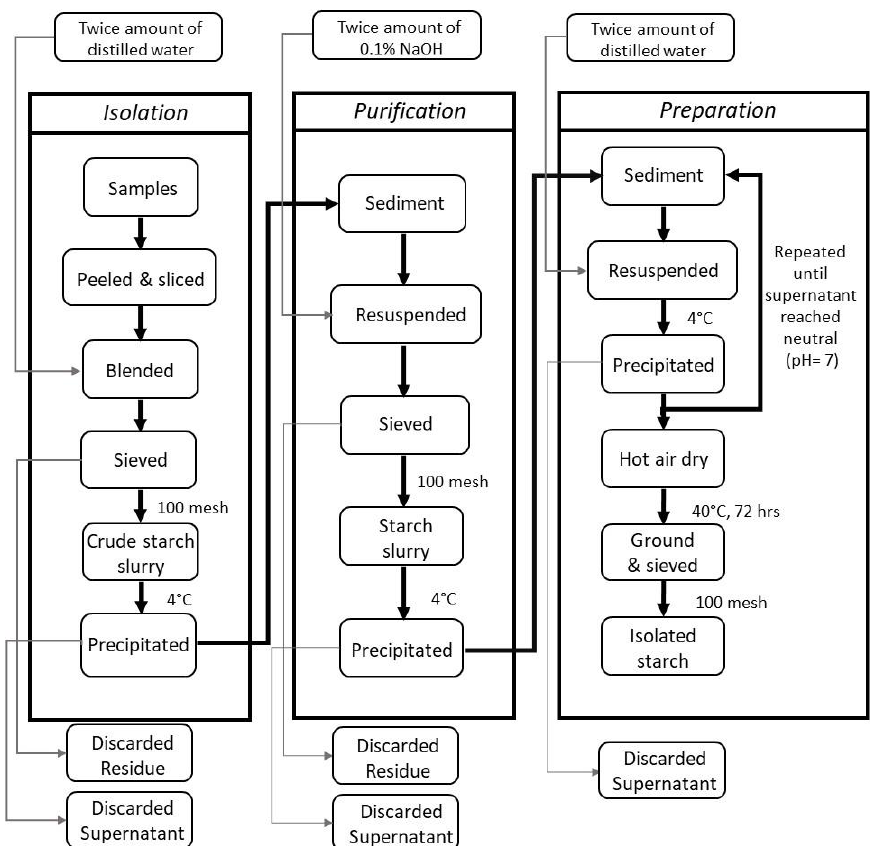
Figure 6. Schematic chart for starch